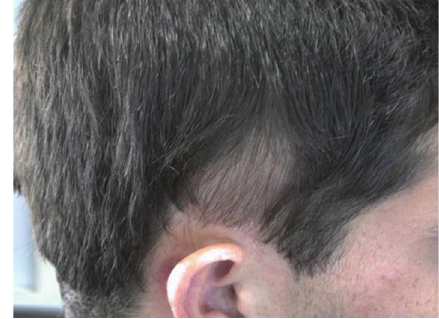
Figure 2: TTA, Right temple.